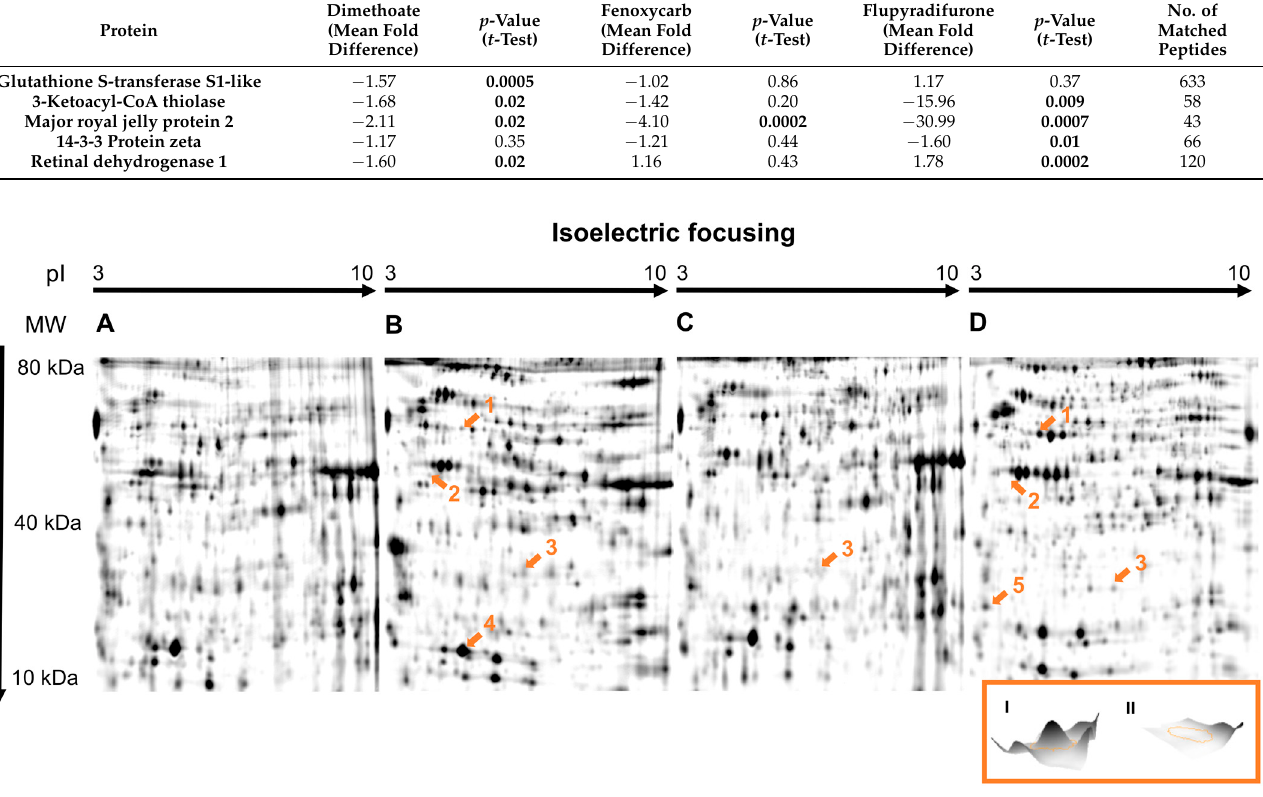
Figure 1. The 2D proteome maps of honey bee larvae exposed to ( A ) solvent control (CS), ( B ) dimethoate (T1), ( C ) fenoxycarb (T2) and ( D ) flupyradifurone (T3). Dysregulated and identified spots are marked with orange numbers and arrows (1: retinal dehydrogenase 1; 2: 3-ketoacyl-CoA thiolase; 3: major royal jelly protein 2; 4: glutathione S-transferase S1-like protein; 5: 14-3-3 protein zeta). MW: molecular weight in kDa; pI: isoelectric point. Inlay (I, II): the 3D profile of 3-ketoacyl-CoA thiolase in control larvae (I) and after exposure to flupyradifurone (II). Table 2. All identified significantly regulated proteins of the three different insecticide treatment groups. Significant changes in relation to their respective solvent controls (CS) are marked in bold.